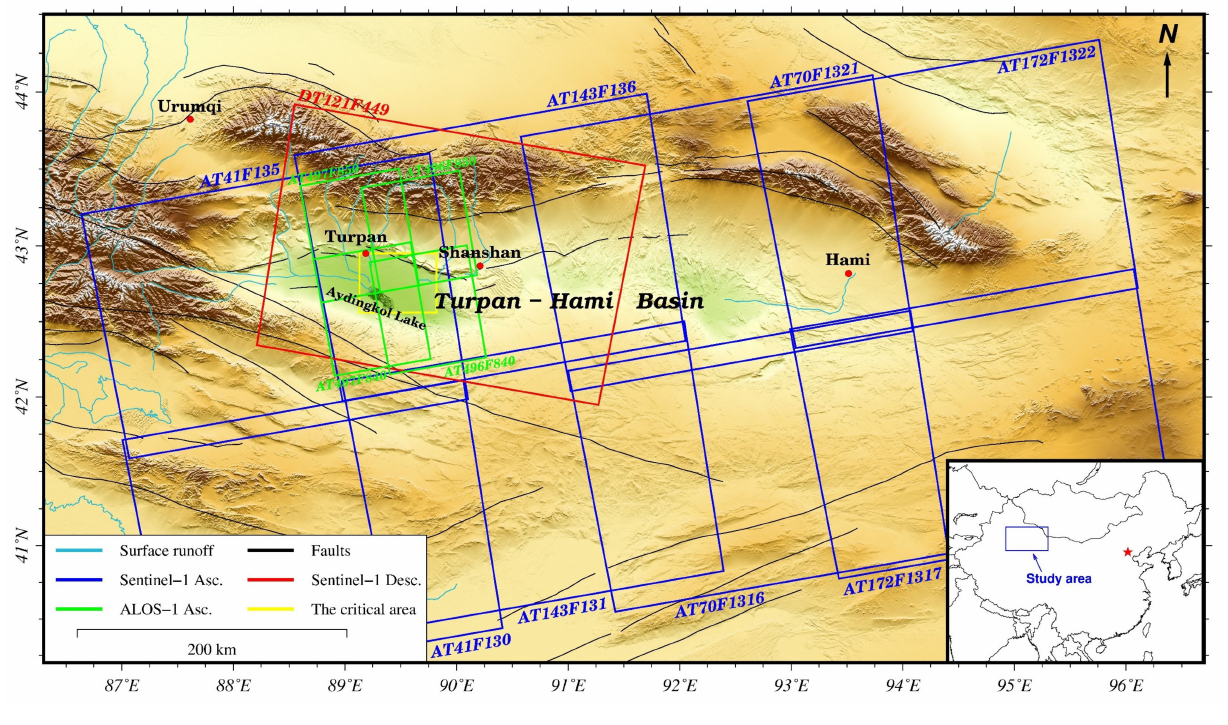
Figure 2. The Turpan–Hami basin and SAR data coverage.